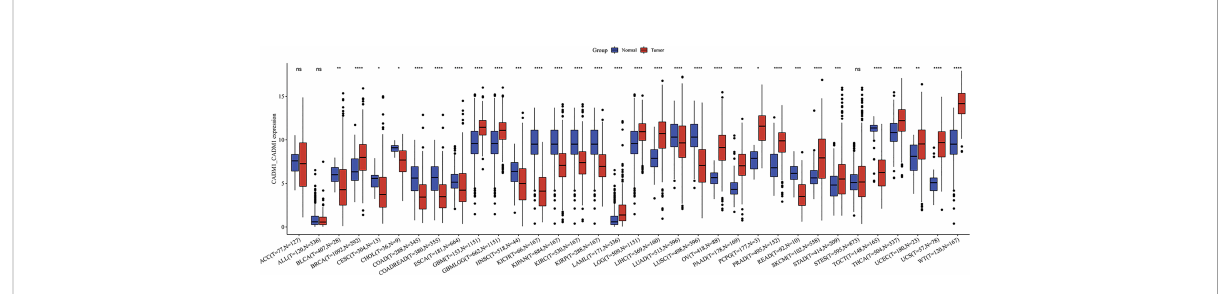
FIGURE 10 The differential expression of CADM1-CADM1 between tumor tissues and normal tissues in pan-cancer (****P < 0.0001, ***P < 0.001, **P < 0.01, *P < 0.05).